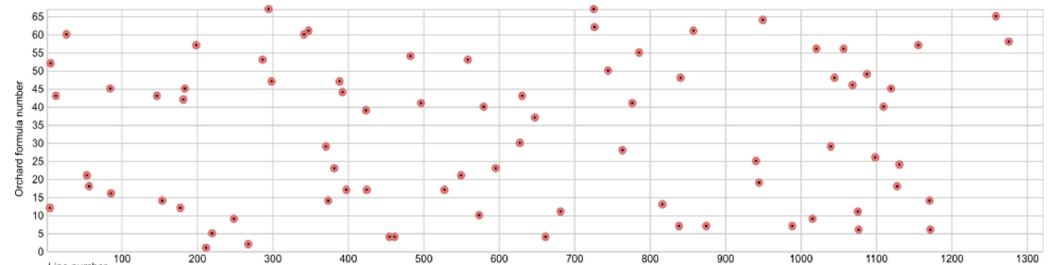
Figure 2. The distribution of Cynewulfian formulae in Elene .